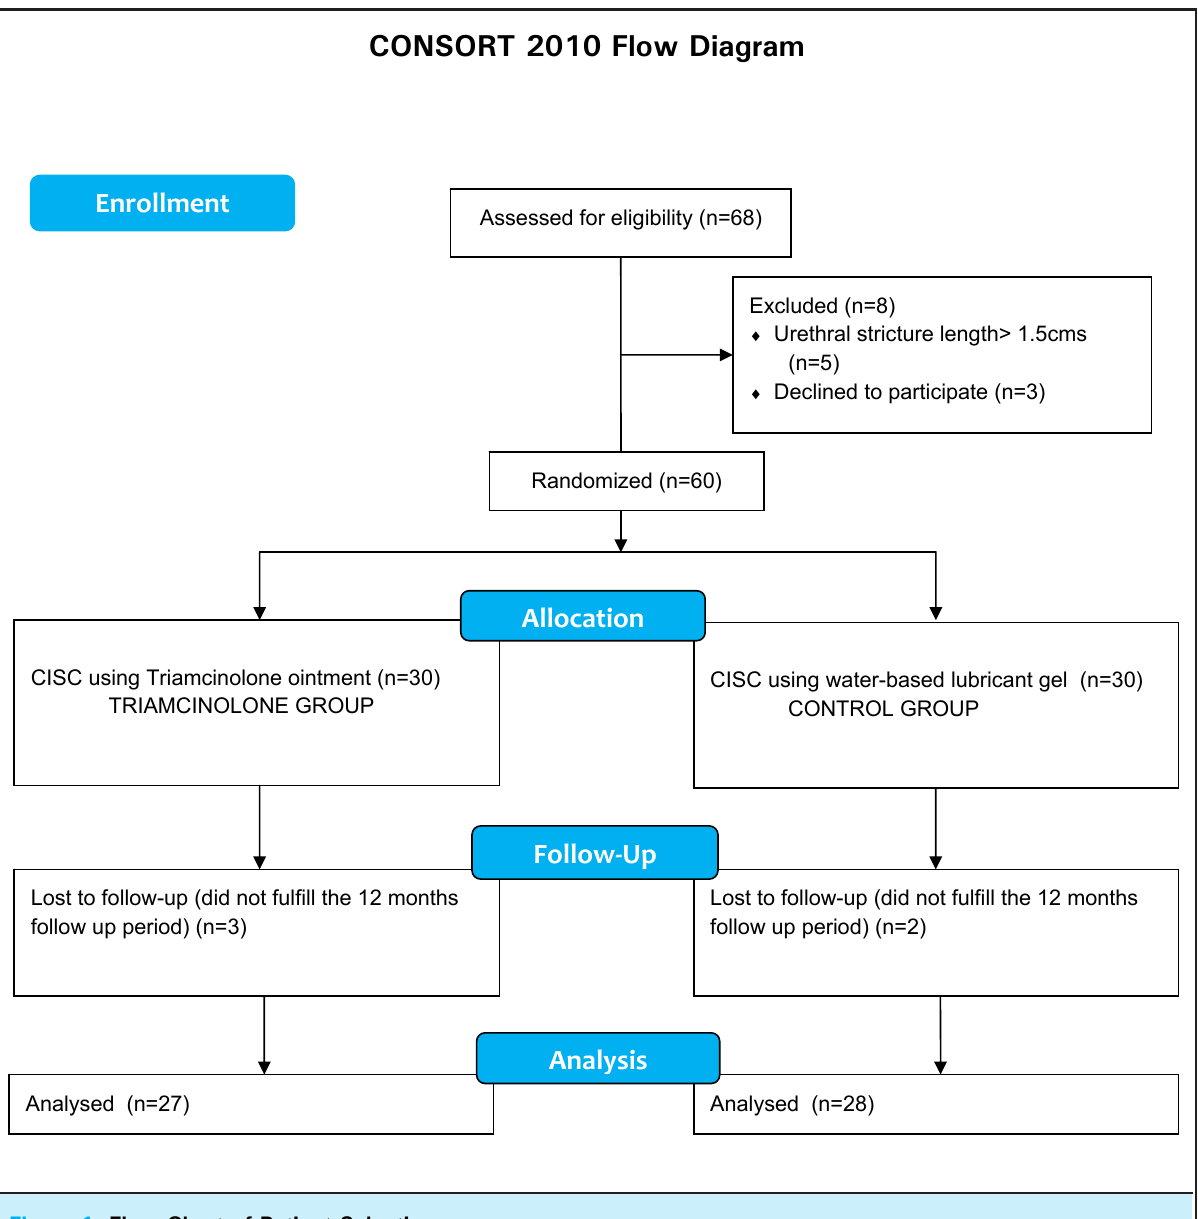
Figure 1. Flow Chart of Patient